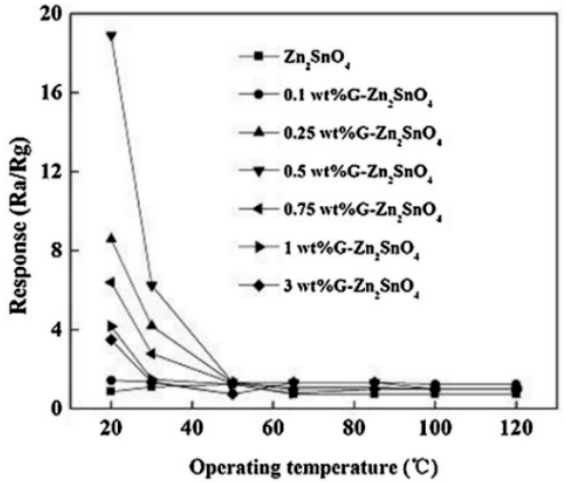
Figure 17. The responses to 1000 ppm formaldehyde vapor of graphene-Zn 2 SnO 4 with different graphene content (0.0, 0.1, 0.25, 0.5, 0.75, 1, and 3 wt%) prepared at 200 °C [72].